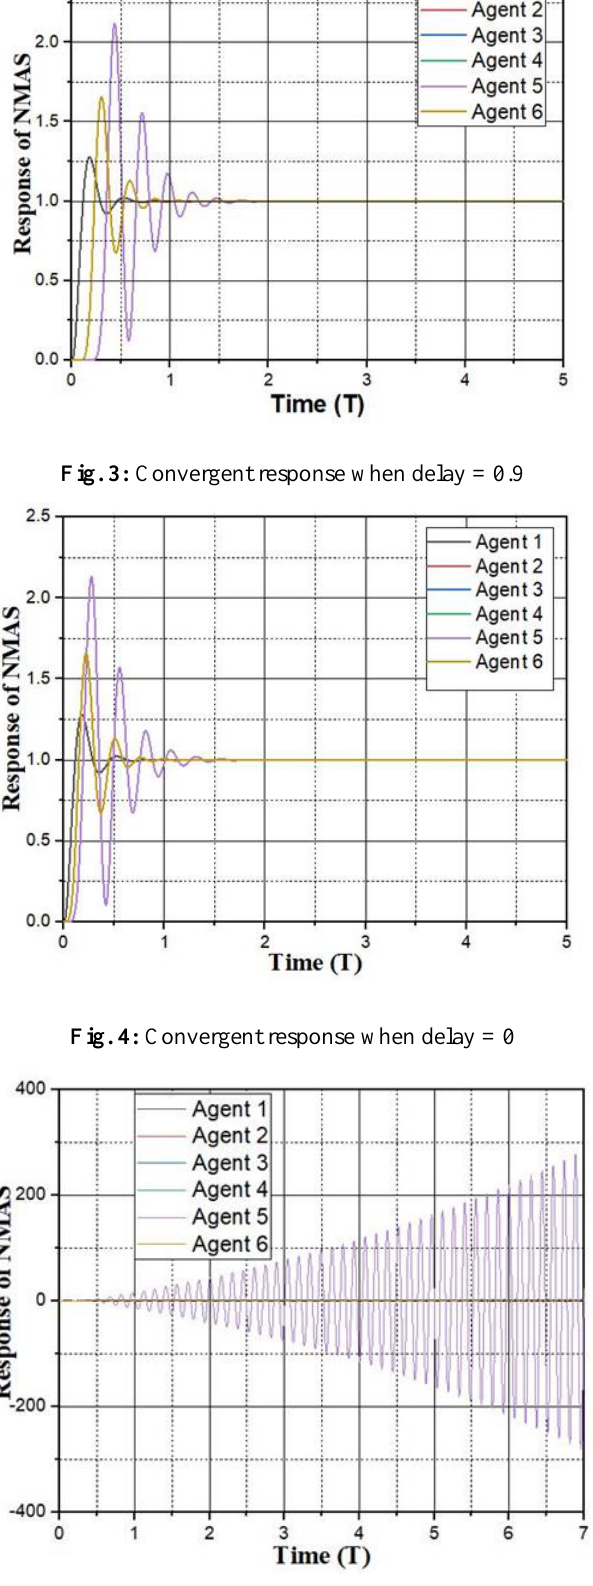
Fig. 5: Divergent response when delay =